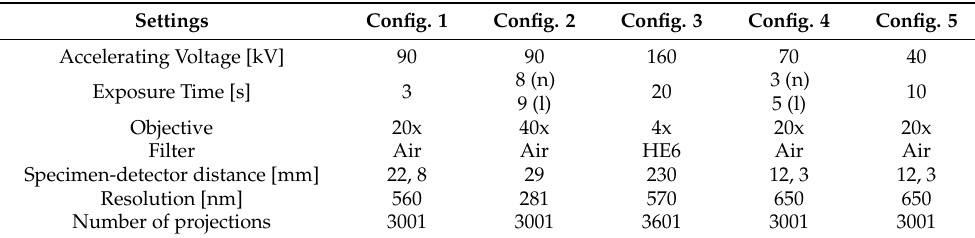
Table 2. Different settings used for 3D X-ray microscopy